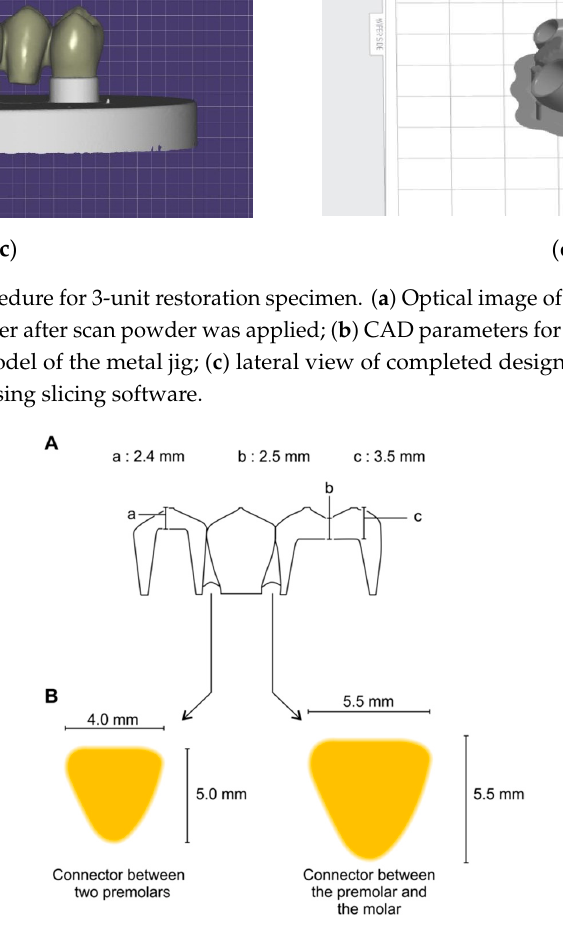
Table 1. Specifications of 3D printing devices.